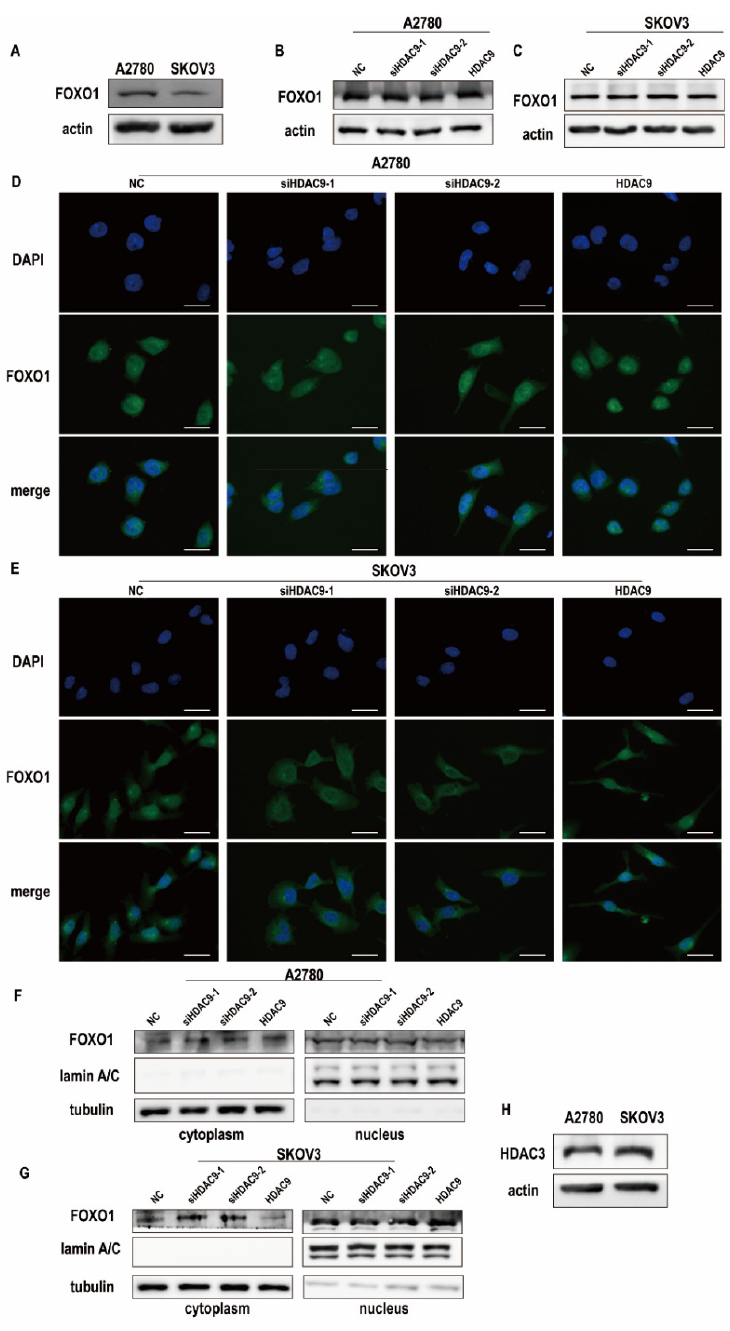
Figure 4. HDAC9 regulates the subcellular localization of forkhead box protein O1 (FOXO1) in SKOV3 cells. ( A ) Western blotting determined the expression of FOXO1 in A2780 and SKOV3 cells. ( B , C ) The expression of FOXO1 in A2780 and SKOV3 cells was measured by Western blot after transfection for 24 h. ( D , E ) Immunofluorescence staining for FOXO1 in A2780 and SKOV3 cells after transfection for 24 h. (bar = 30 um). ( F , G ) After transfection for 24 h, the nucleus of A2780 and SKOV3 cells were isolated and the expression of FOXO1 was investigated. ( H ) Western blotting determined the expression of HDAC3 in A2780 and SKOV3